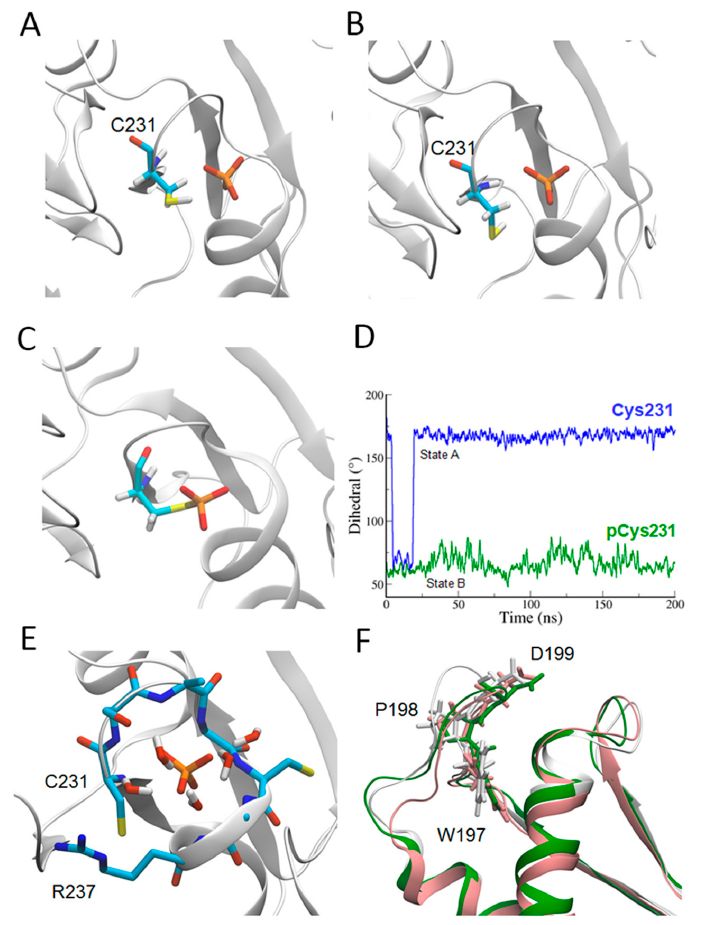
Figure 3. PTPN12 in molecular dynamics (MD) simulations. Panels ( A , B ) show two snapshots of two different states of C231 along the MD trajectory, which correspond to configurations in which the dihedral angles between the main chain and the side chain of the cysteine are, respectively, 70° or 170°. In the presence of the phosphoryl–cysteine, no transition was observed, as shown in panel ( C ), and graphically in panel ( D ); Panel ( E ) shows the positions of water molecules in the MD simulation. The spatial distribution of the water molecules in the simulation was slightly different due to the conformational change initiated by the bond breaking between C231 and the phosphate ion. Panel ( F ) shows the comparison between the loop containing the WPD motif in the crystal structure ( green ), in the MD model in the presence ( white ) or absence of the phosphate ion ( pink ). Figure 3A–C,E,F were